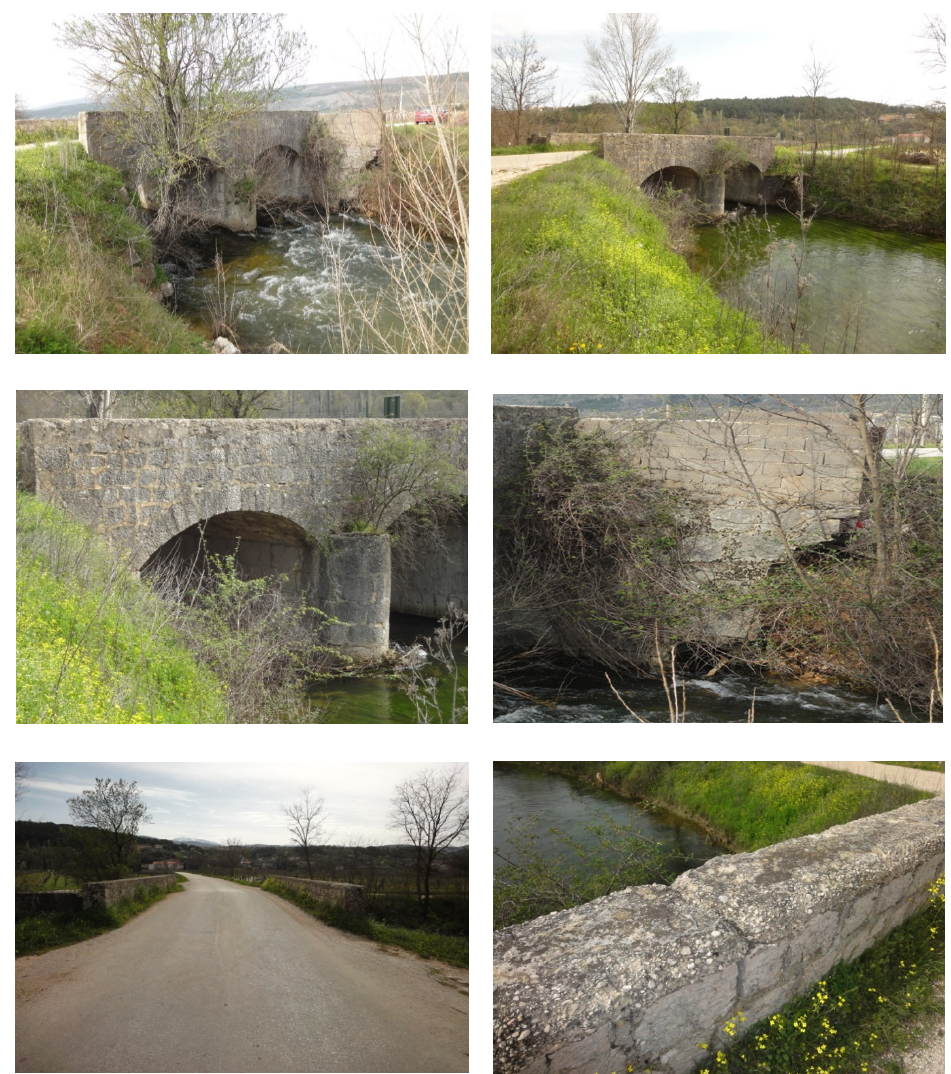
Figure 4. Bridge on the river Jaruga nearby Mraˇcaj in Imotski field (figures in order from above left: bridge from east side, bridge from west side, abutment wing, pier, access road, fence).